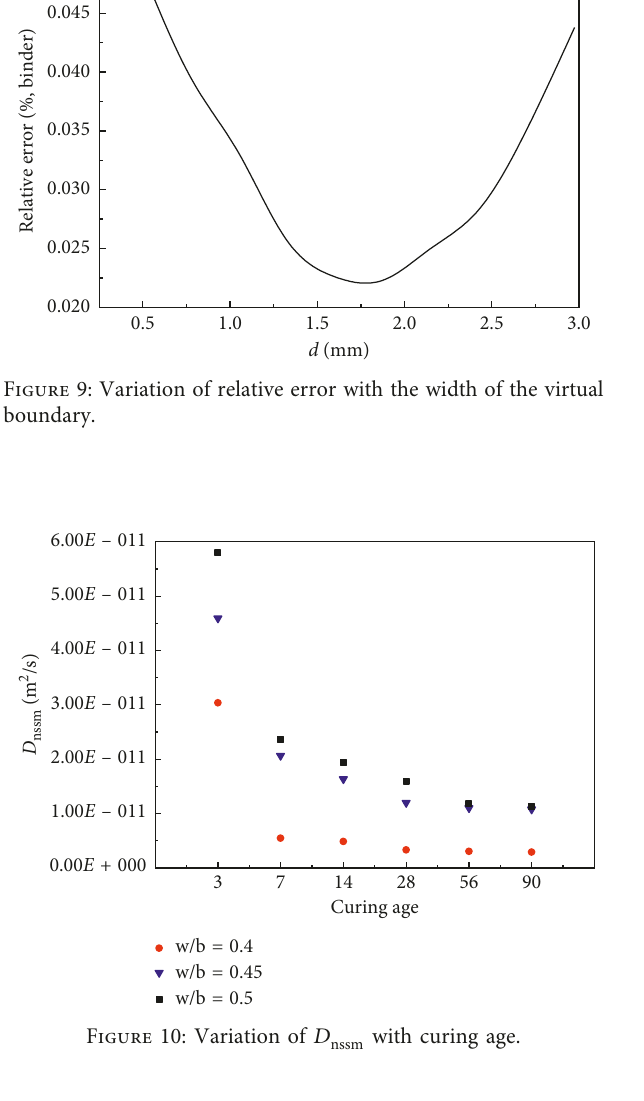
with curing age. nssm